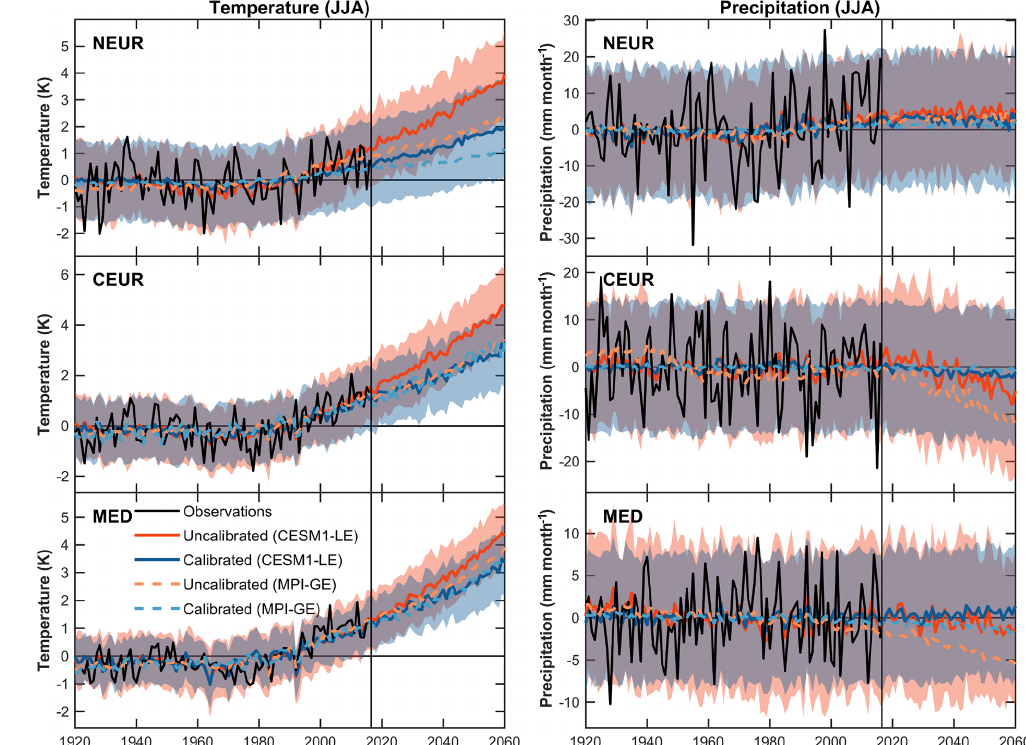
Figure 7. Uncalibrated and calibrated (HGR-decomp) CESM1-LE projections, where here the calibrated projections have been calibrated against the observations over the period 1920–2016. The lines show the ensemble medians for the uncalibrated and calibrated ensembles for both the CESM1-LE (solid) and MPI-GE (dashed) datasets. The shading shows the 5–95% range of the CESM1-LE ensemble. Based on the verification out-of-sample tests using the CMIP5 models the calibrated ensemble is expected to be more reliable than the uncalibrated ensemble, particularly for